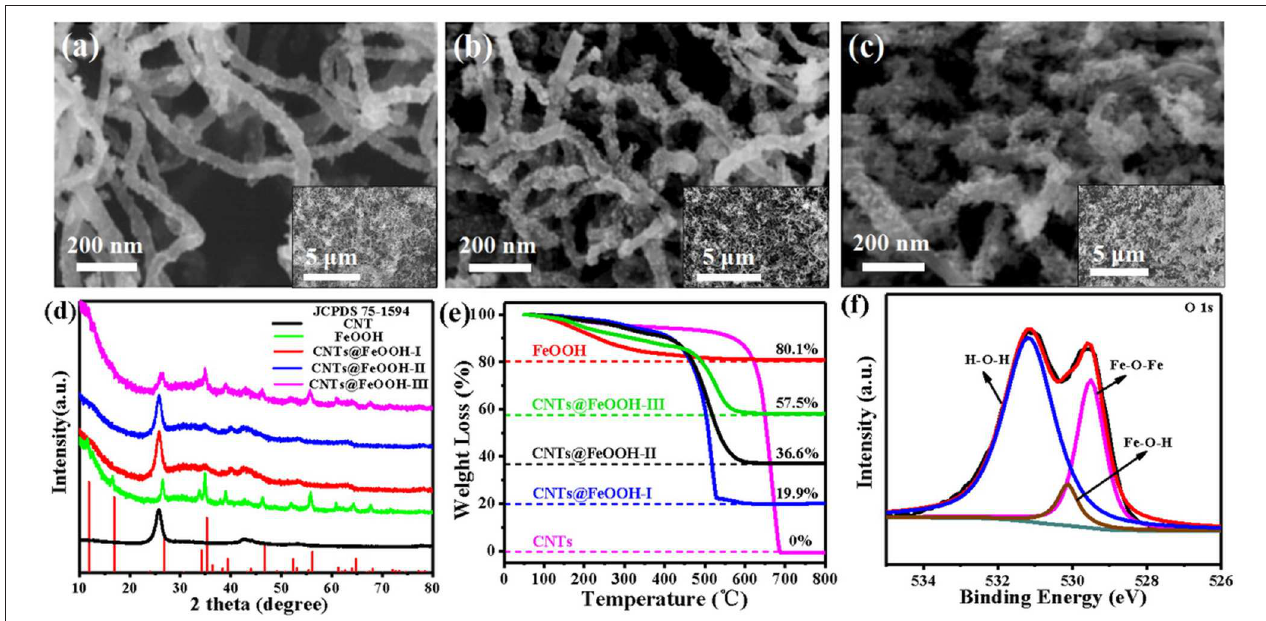
FIGURE 1 | SEM images of (a) CNTs@FeOOH-I, (b) CNTs@FeOOH-II, (c) CNTs@FeOOH-III; (d) XRD, and (e) TGA of carboxylic CNTs, bare FeOOH and CNTs@FeOOH compounds with different proportions; (f) XPS spectra results of CNTs@FeOOH-II compounds: O 1s core-level spectrum.